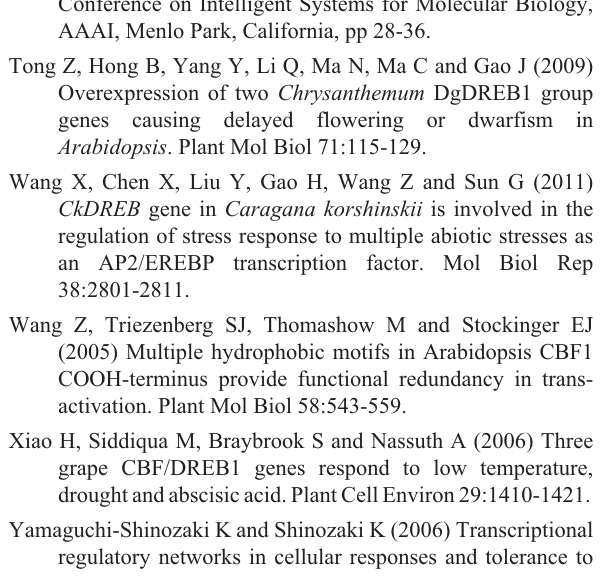
Figure S1 - Nucleotide and deduced amino acid sequences of actin1 and EF1. Figure S2 - Melting curves. Figure S3 - Cloning of DREB1 from Iceland poppy. Figure S4 - Motif logos in 36 DREB1s. Table S1 – Primer